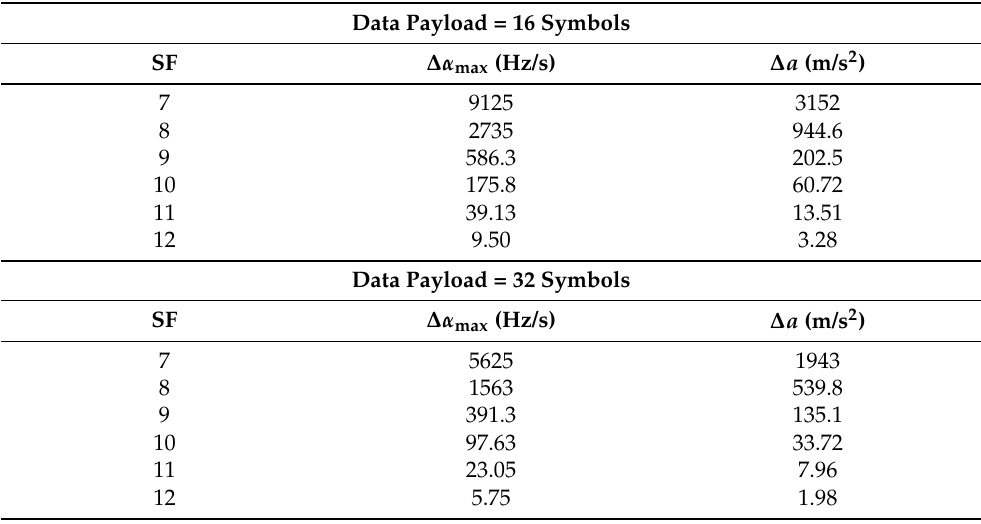
Table 2. Reference values for ∆ α max and ∆ a . ( B = 125kHz and F =